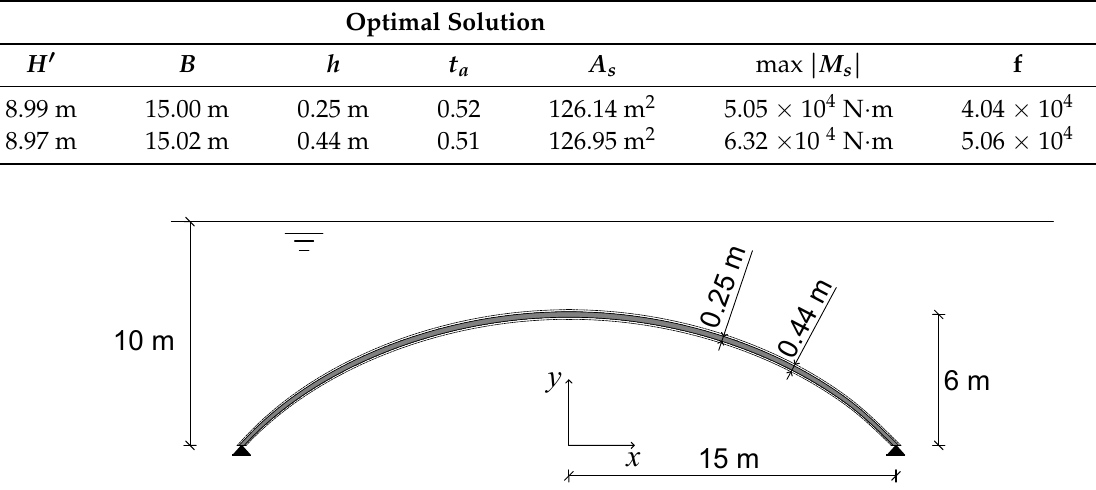
Figure 4. Arch shapes comparative for linear and nonlinear solutions for the case in which the height H is fixed. Note that both curve guidelines are coincident and the thickness of the non-linear solution is represented with external dashed